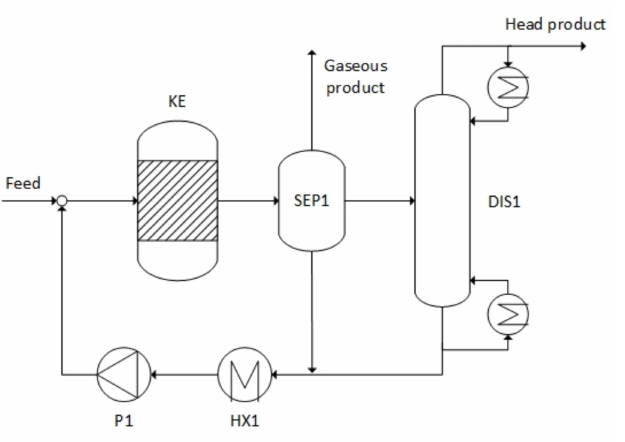
Figure 4. Process flow diagram for the production of n-octane via Kolbe electrolysis (KE: Kolbe electrolysis, SEP1: liquid–liquid–gas separation, DIS1: distillation, HX1: heat exchanger, P1: pump).